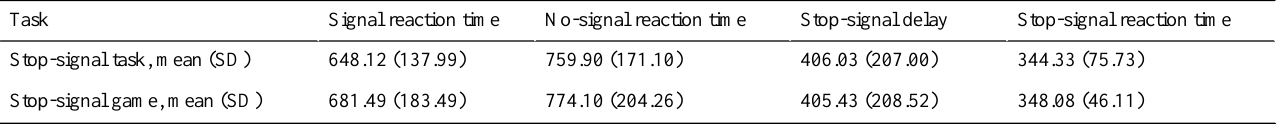
Table 6. Mean reaction time in milliseconds dependent on the task type for study